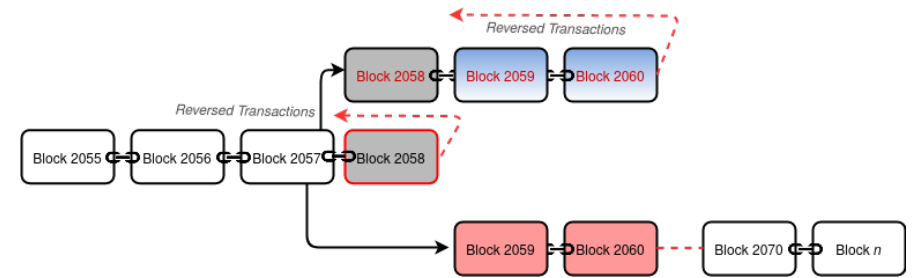
Figure 3. A 51% attack scenario where the attacker executes